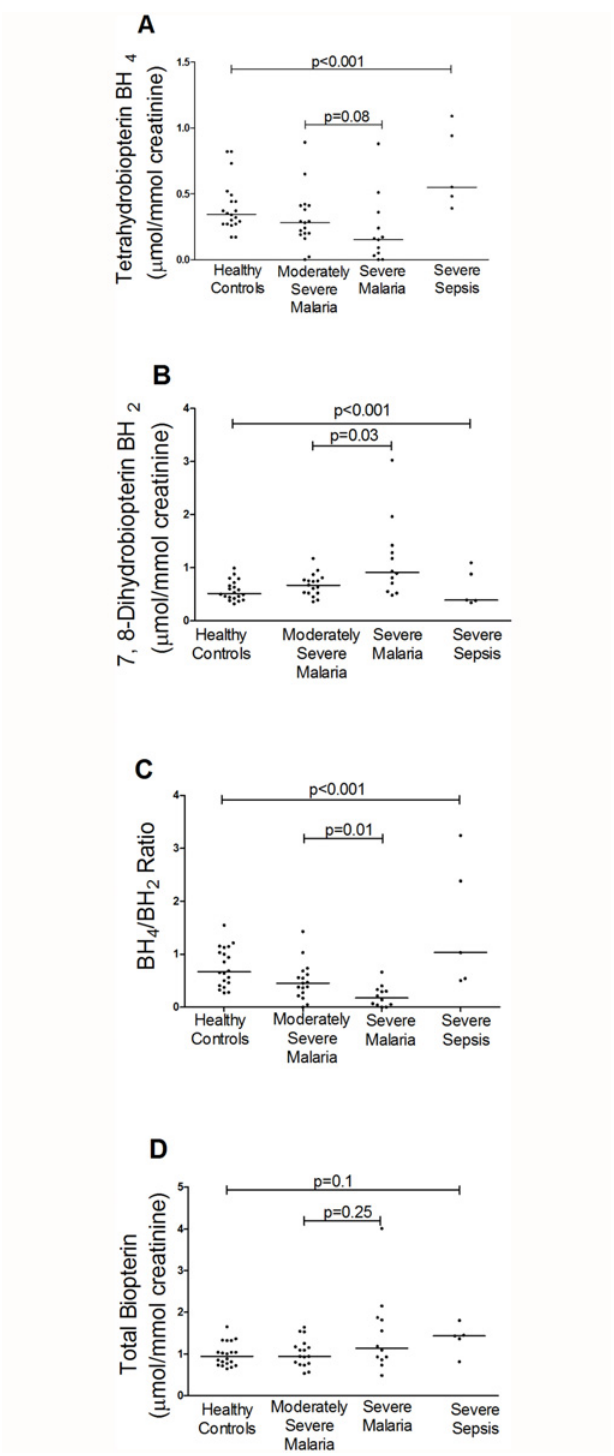
Fig 1. Urinary BH4, BH2 concentrations, BH4/BH2 ratios and Biopterin concentration in each group on enrollment (Kruskal-Wallis: p < 0.001). Horizontal bars represent pairwise comparisons between disease groups. A. Urine BH4 ( μ mol/mmol creatinine) concentrations in each group on enrollment. Horizontal lines indicate median values for each group. B. Urine BH2 ( μ mol/mmol creatinine) concentrations in each group on enrollment. Horizontal lines indicate median values for each group. C. BH4/BH2 ratio in